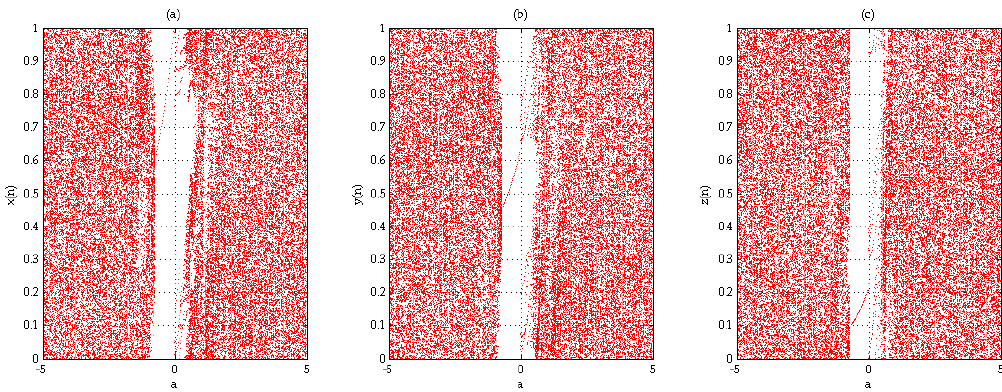
Figure 4. Three-dimensional bifurcation diagram of system (2): ( a ) a -X bifurcation diagram; ( b ) a -Y bifurcation diagram; ( c ) a -Z bifurcation diagram.